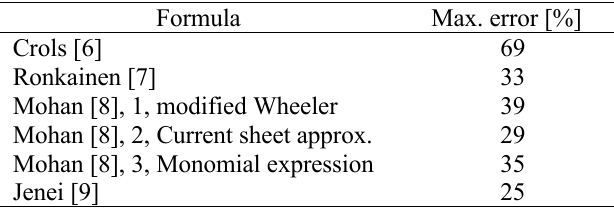
Table 4: Maximum errors from Table